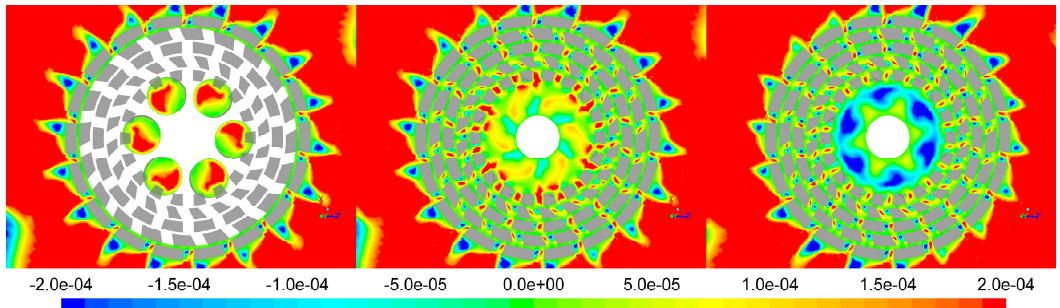
Figure 9. Parameter u RAD Ca C /G (m) at 6000 rpm for the same planes as in Figure 4.